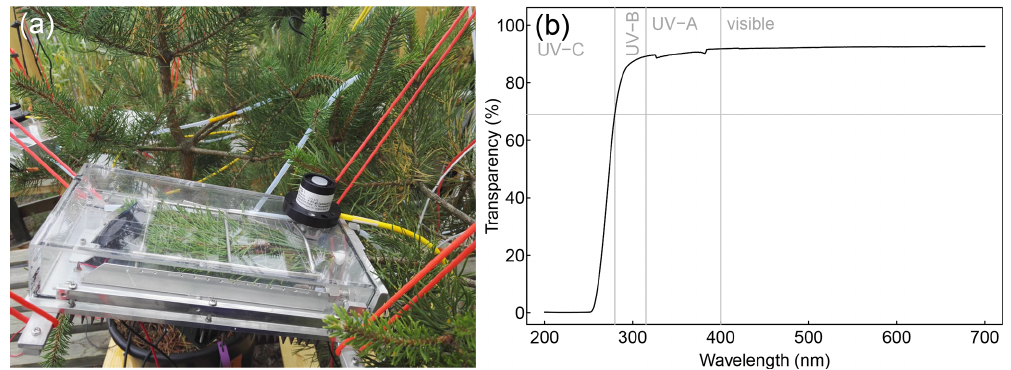
Figure 2. Picture of the shoot enclosures used for ShoTGa-FluMS (a) and the UV–Vis transmission spectrum of the transparent chamber cover (b)